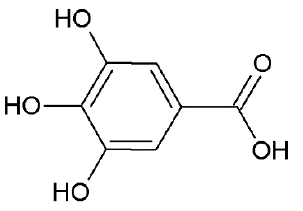
Figure 1. Chemical structure of gallic acid.